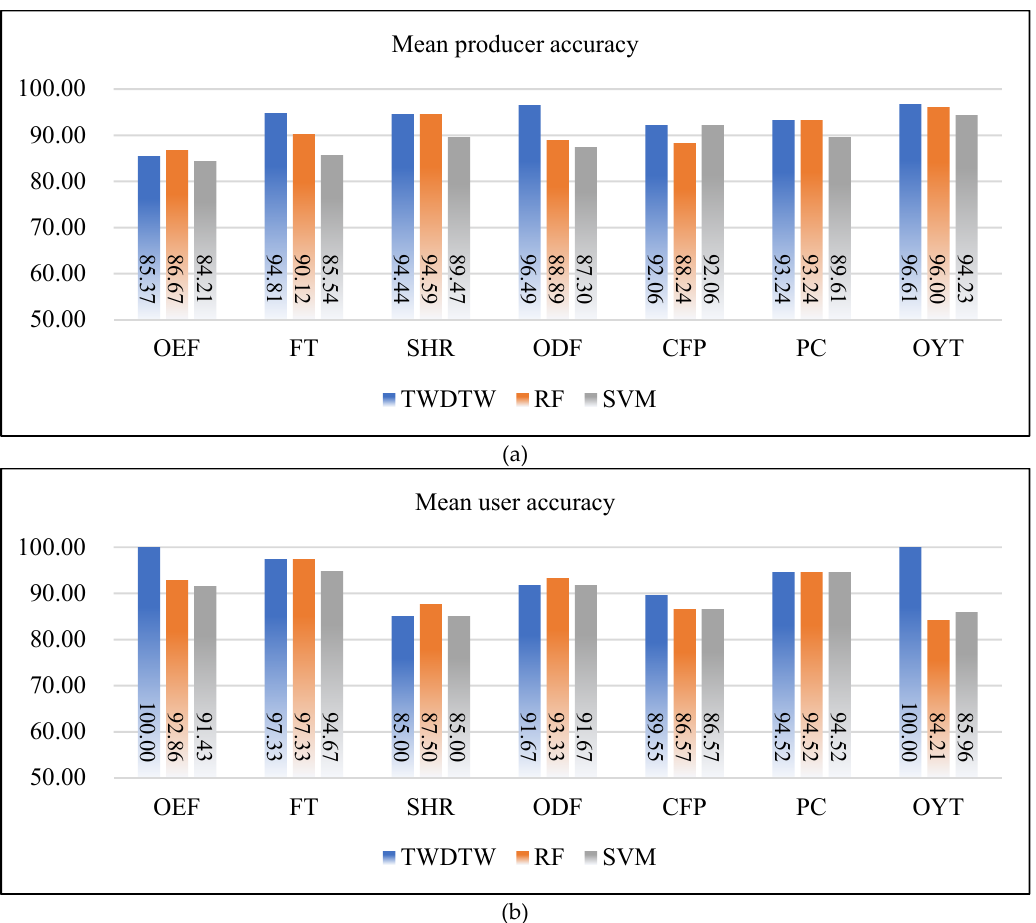
Figure 6. Comparison of forest-type classification accuracy using TWDTW, RF, and SVM methods.